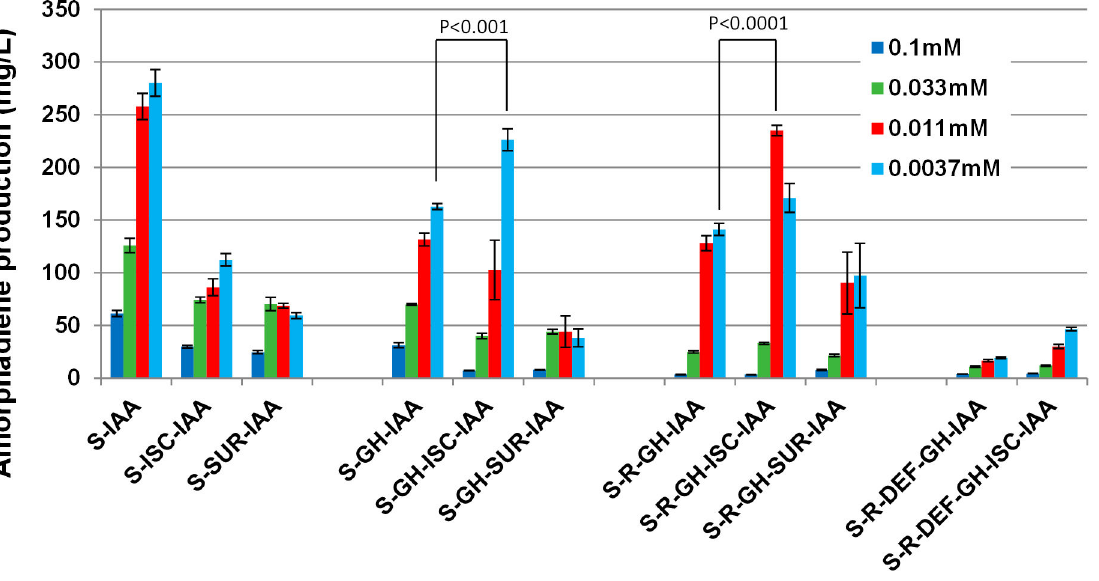
Figure 6. The effects of Fe-S operons on the amorphadiene production. Different concentrations of IPTG were represented by bars with different colors. The experiment was repeated four times and the standard errors of four replicates were presented as error bars. The two tailed p-values of student’s t-test were carried out to compare certain conditions and presented as P in the